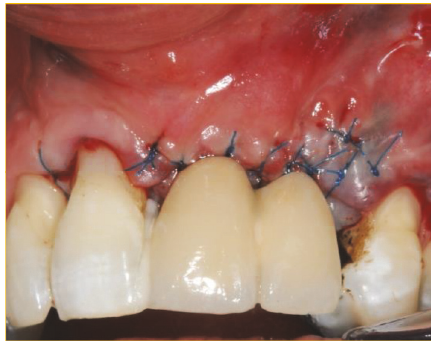
Figure 14: Temporary adhesive bridge has been placed, replacing teeth 21 and 22 and protecting the surgical site.